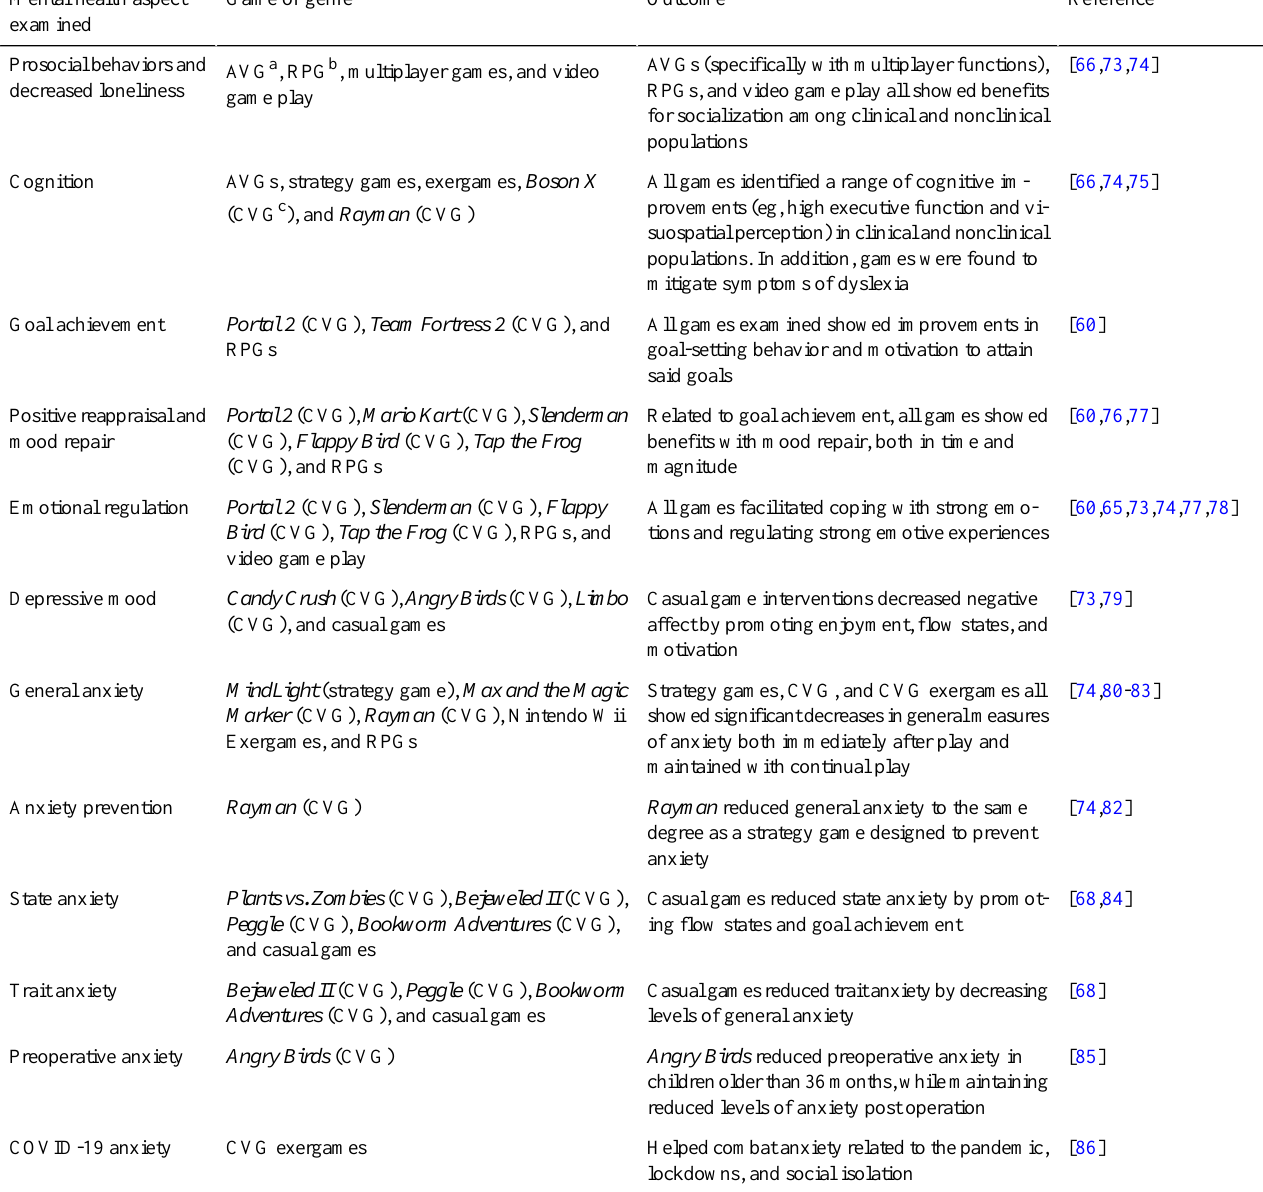
Table 1. Selected studies of commercial video games and their reported positive mental health outcomes related to depression and anxiety. ReferenceOutcomeGame or genreMental health